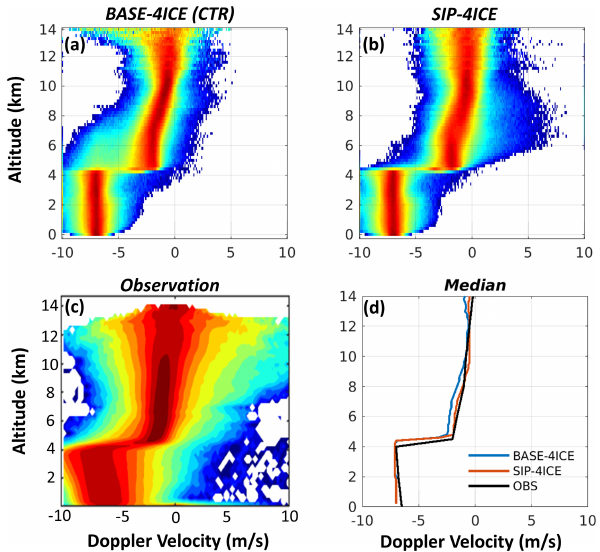
Figure 16. Same for Fig. 12 but for the Doppler